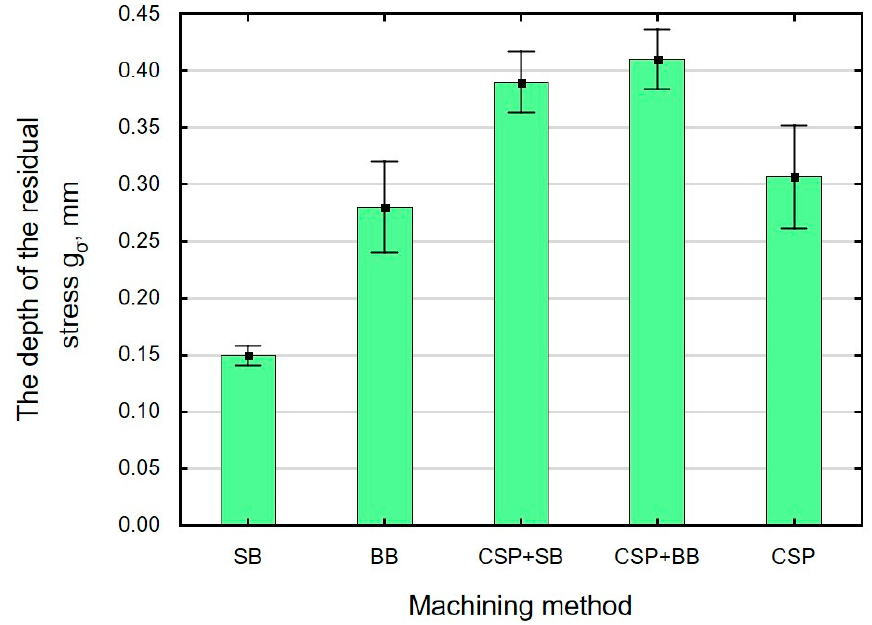
Figure 14. Finishing treatment versus residual compressive stresses g σ (SB—sidle burnishing, BB— ball burnishing, CSP + SB—centrifugal shot peening + sidle burnishing, CSP + BB—centrifugal shot peening + ball burnishing, CSP– centrifugal shot peening).